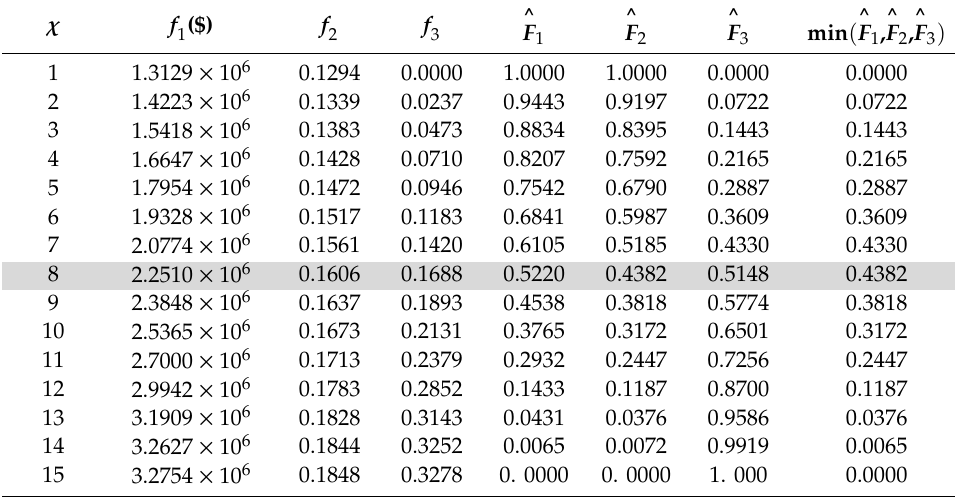
Table 10. Obtained Pareto optimal solutions for the probabilistic multi-objective RPP considering the load demand